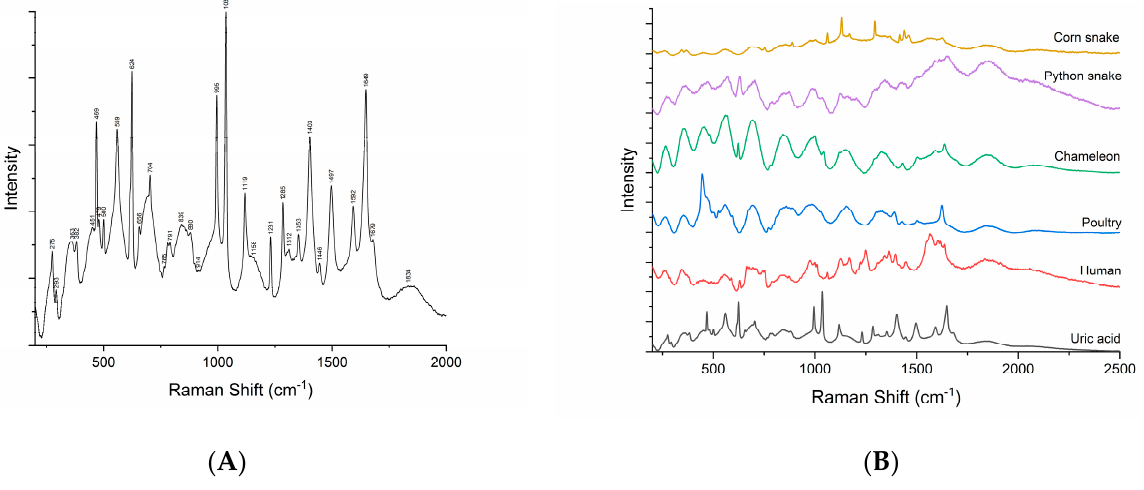
Figure 3. Raman spectra of uric acid ( A ) and comparison between samples vs. uric acid ( B ).